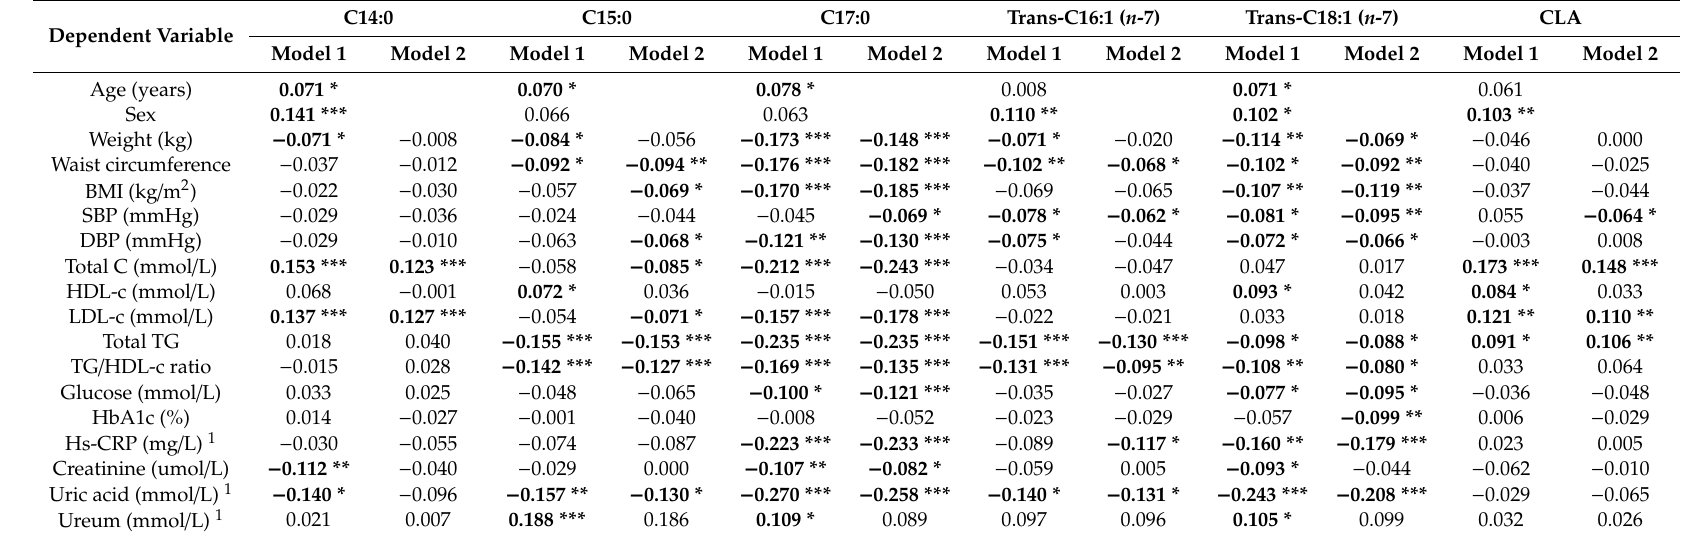
Table 3. Association between circulating fatty acid markers from plasma Phospholipids (PL) and cardiovascular risk